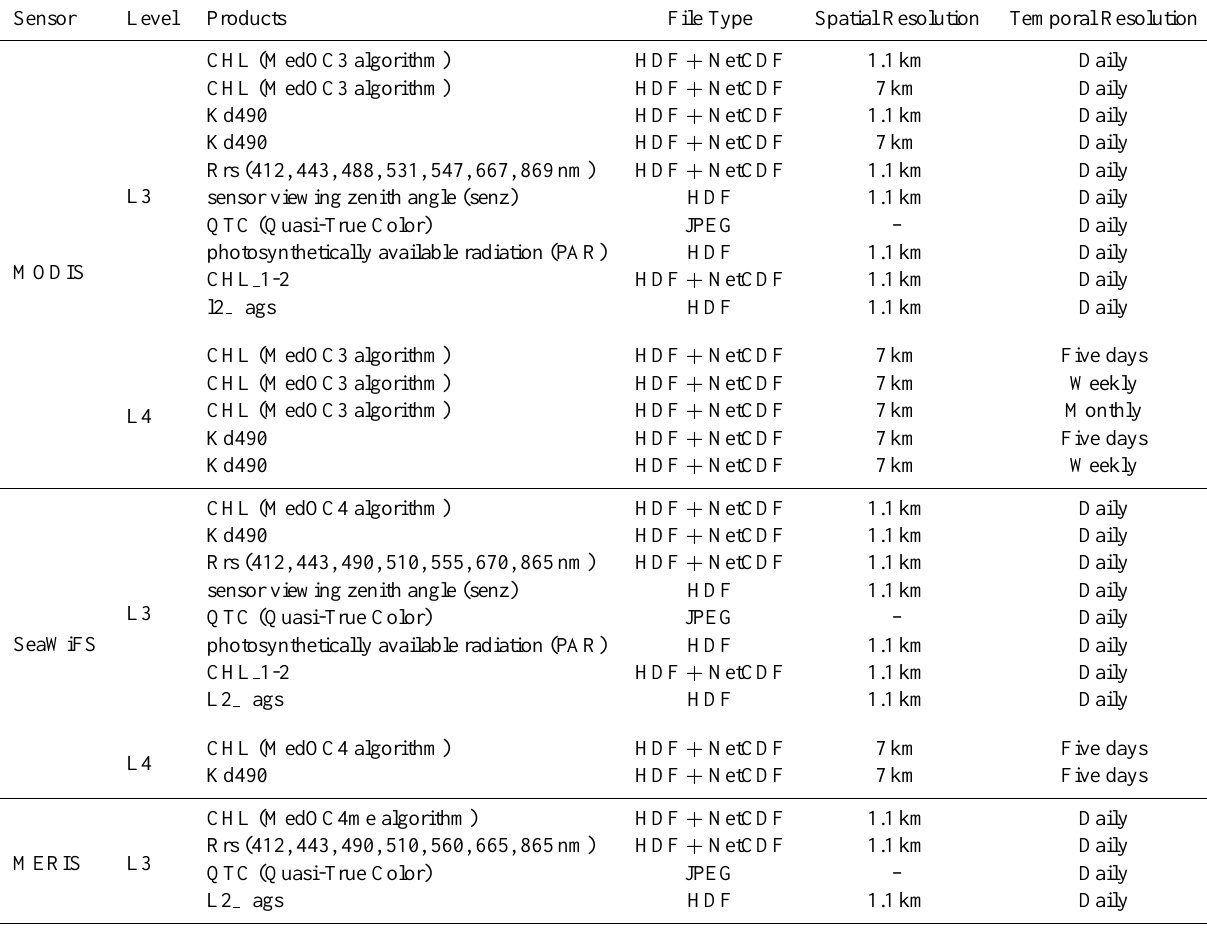
Table 1. OCOS products list routinely generated at GOS. For each product the sensor (MODIS, SeaWiFS or MERIS) is specified, along with the processing level, the data file format, and space-time data